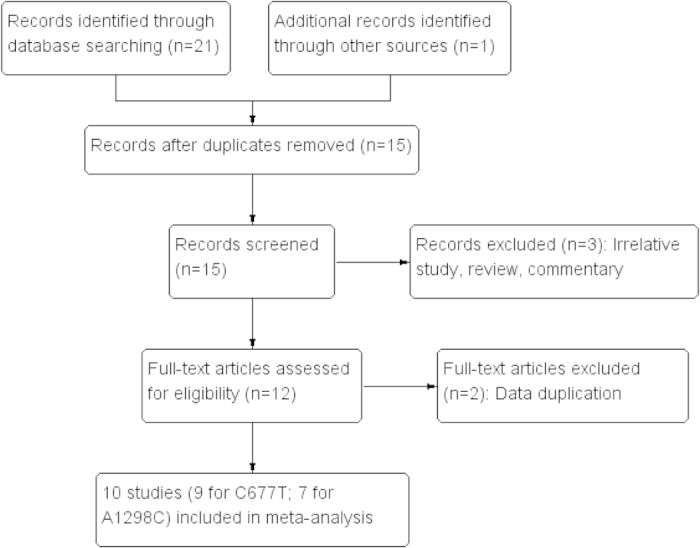
Flow diagram of study selection.